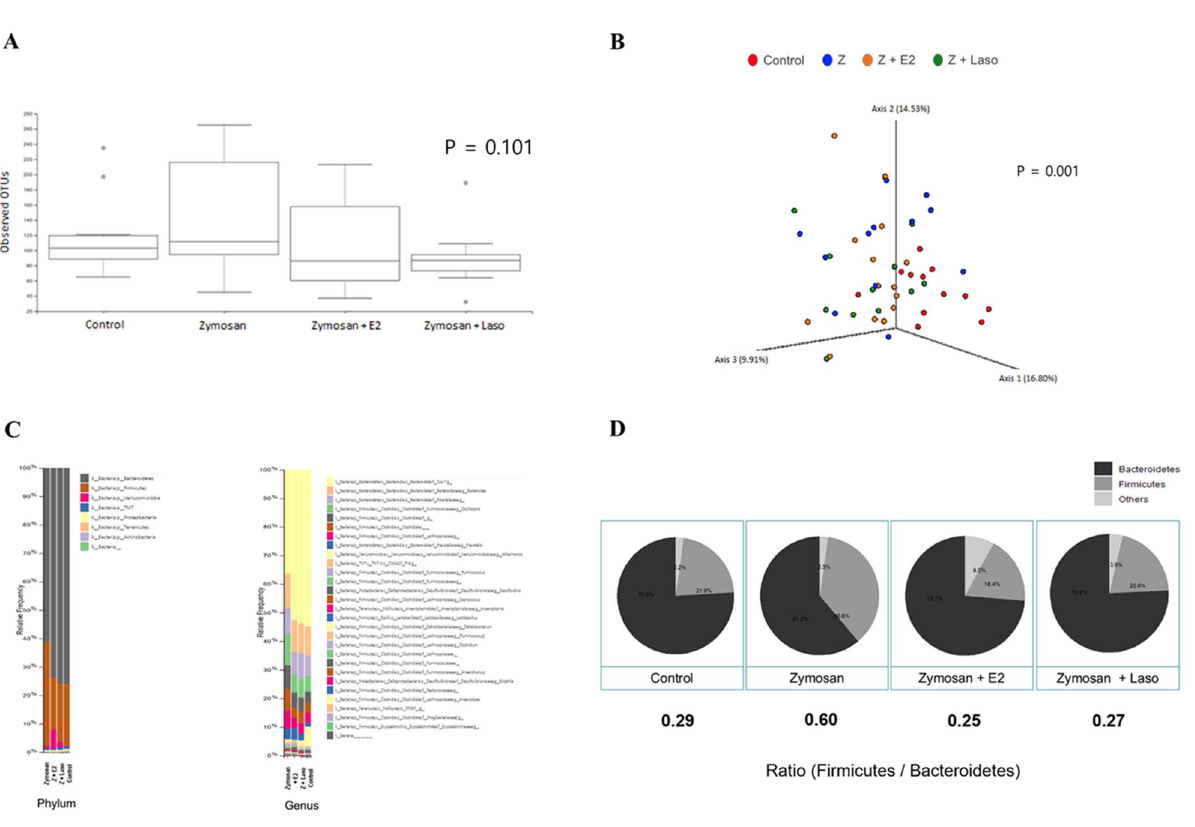
Figure 5. Bacterial composition of the gut microbiota. ( A ) α-diversity of gut microbiota between groups are measured by Shannon diversity index. The horizontal line inside the box represents the median, and the bottoms and tops of the boxes represent the 25th and 75th percentiles, respectively. Whiskers represent the lowest and highest values within the 1.5 interquartile range, respectively. Outliers are shown as dots. There was no statistical significance by Kruskal–Wallis test. ( B ) β-diversity, represented by principal coordinate analysis, was determined by Bray–Curtis distance matrices. Statistical significance was calculated using permutation multivariate analysis of variance test for β-diversity. ( C ) Global distribution of gut microbiota at phylum and genus levels. Subgroups are labelled on the X-axis and expressed as the relative operational taxonomic unit (OTU) abundance for each group. ( D ) Firmicutes/Bacteroidetes (F/B) ratio in phyla level were determined in control, zymosan (Z), Z + 17β-estradiol (E2), and Z + lasofoxifene (Laso) treated group ( p = 0.059). F/B ratio was of Z group was lower than other three groups ( p = 0.073). Analysis were performed using QIIME2 software (https:// qiime2. org) and R studio (https:// www. rstud io.